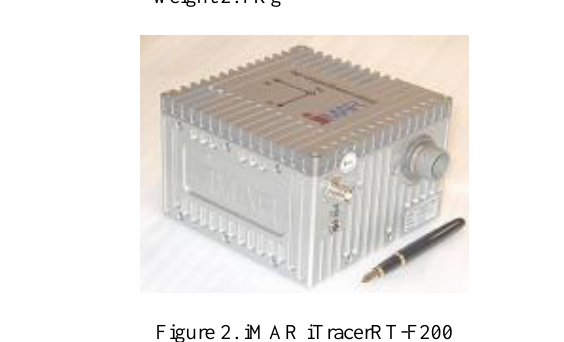
Figure 2. iMAR iTracerRT-F200